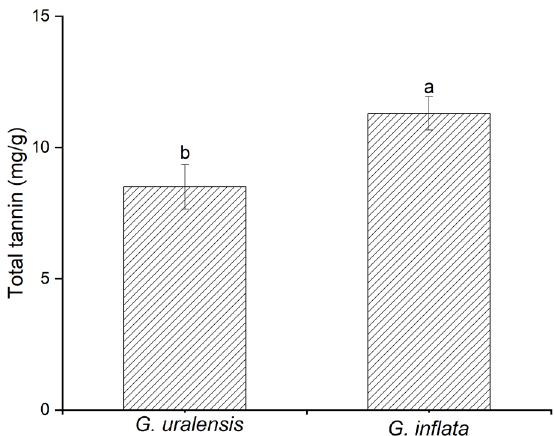
Figure 5. Leaf nitrogen content of two licorice ( Glycyrrhiza ) species. Means with differing letters are significantly different (P < 0.01).